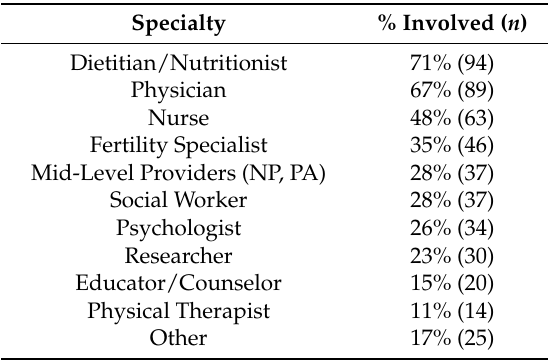
Table 3. Types of specialty providers involved in multidisciplinary PCOS clinics ( n = 132).